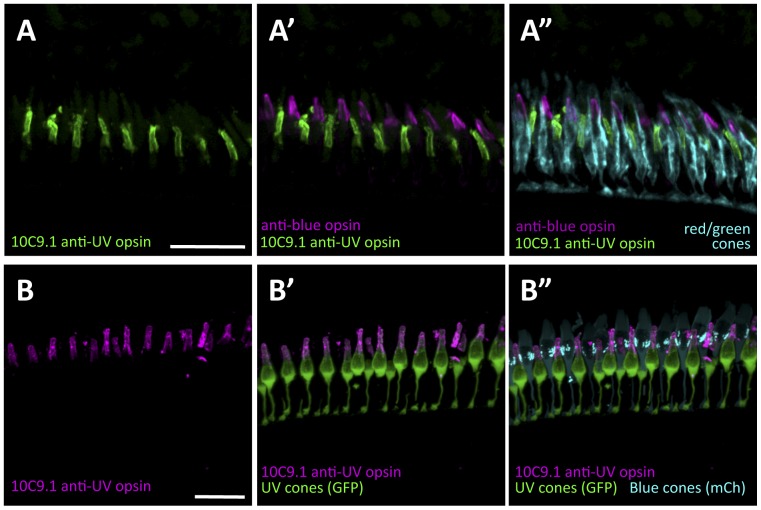
A monoclonal antibody raised in rat (10C9.1) labels zebrafish UV cone outer segments, allowing all cone subtypes to be simultaneously labeled by immunohistochemistry.Antibody 10C9.1 specifically labels the outer segments of a class of short single cones in the adult zebrafish retina (Figure S1 panel A). 10C9.1 specificity is supported (see Figure S1 panels B–D), including by a dramatic decrease in number of cells labeled when 10C9.1 is applied to retinas from zebrafish mutants (tbx2blor/lor) that have a paucity of UV cones. A. The population of single cones labeled by 10C9.1 is the UV cones, because established antibodies against the other single cone class, the blue cones, labels a distinct cone population (A′). 10C9.1 enables an unprecedented combination of antibodies raised in different species that simultaneously label and distinguish all cone photoreceptor subtypes (A”). E. Further evidence that 10C9.1 labels UV cone outer segments comes from its co-localization with UV cones filled with green fluorescent protein (GFP), and its exclusion from blue cones filled with mCherry (mCh) in transgenic zebrafish (Tg(-5.5opn1sw1:EGFP)kj9;Tg(-3.5opn1sw2:mCherry)ua3011). Panel B is available as Movie S1. Scale bars 30 μm.